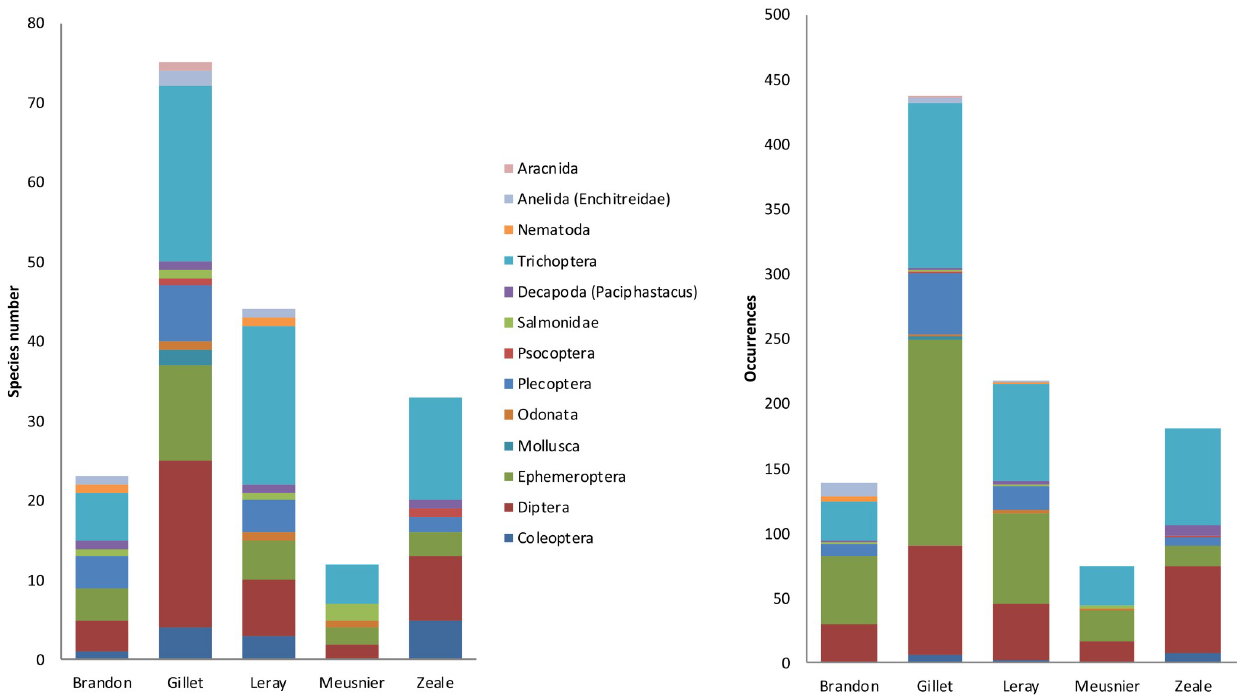
Fig 4. Number of OTUs assigned to species and their occurrences for each primer set. Results taking into account high taxonomical levels.